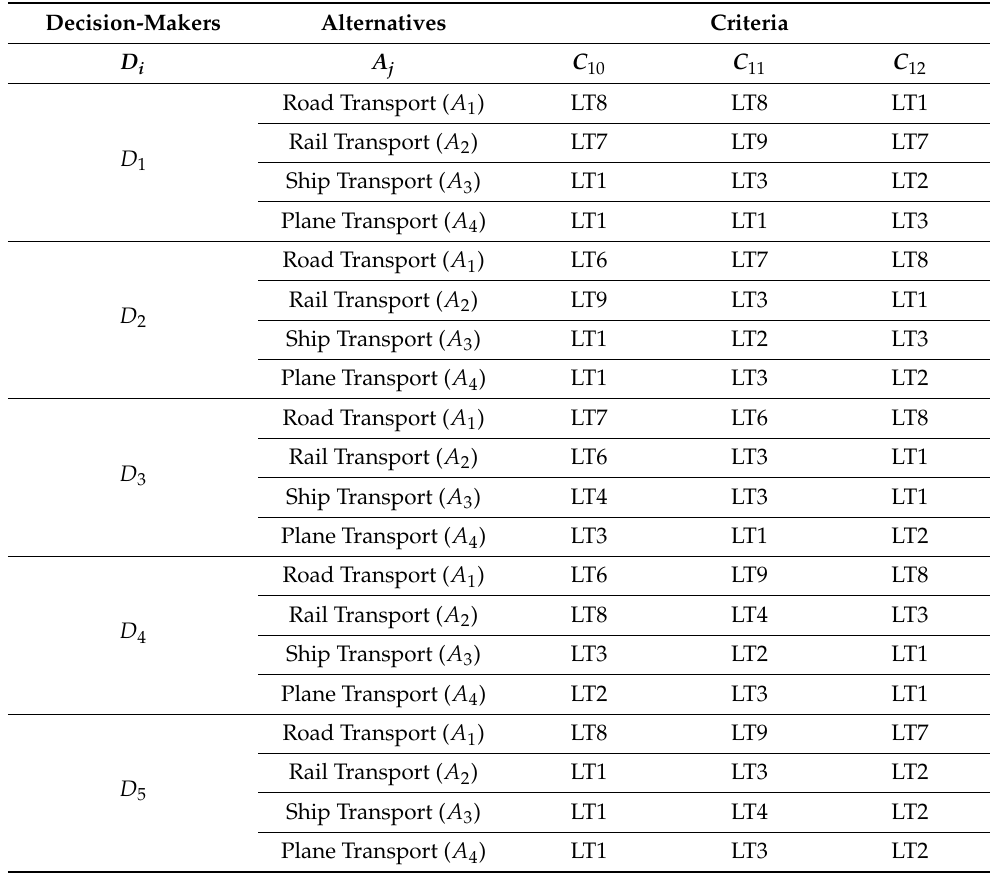
Table 7. Environmental factors preference performance matrix employing linguistic terms, based on decision-maker